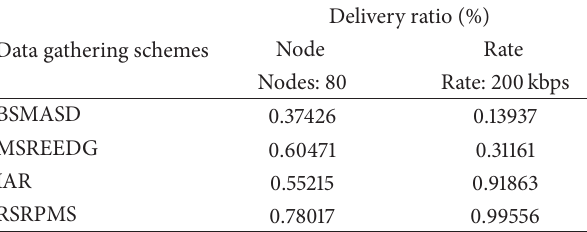
Table 1: Delivery ratio of the data gathering schemes.